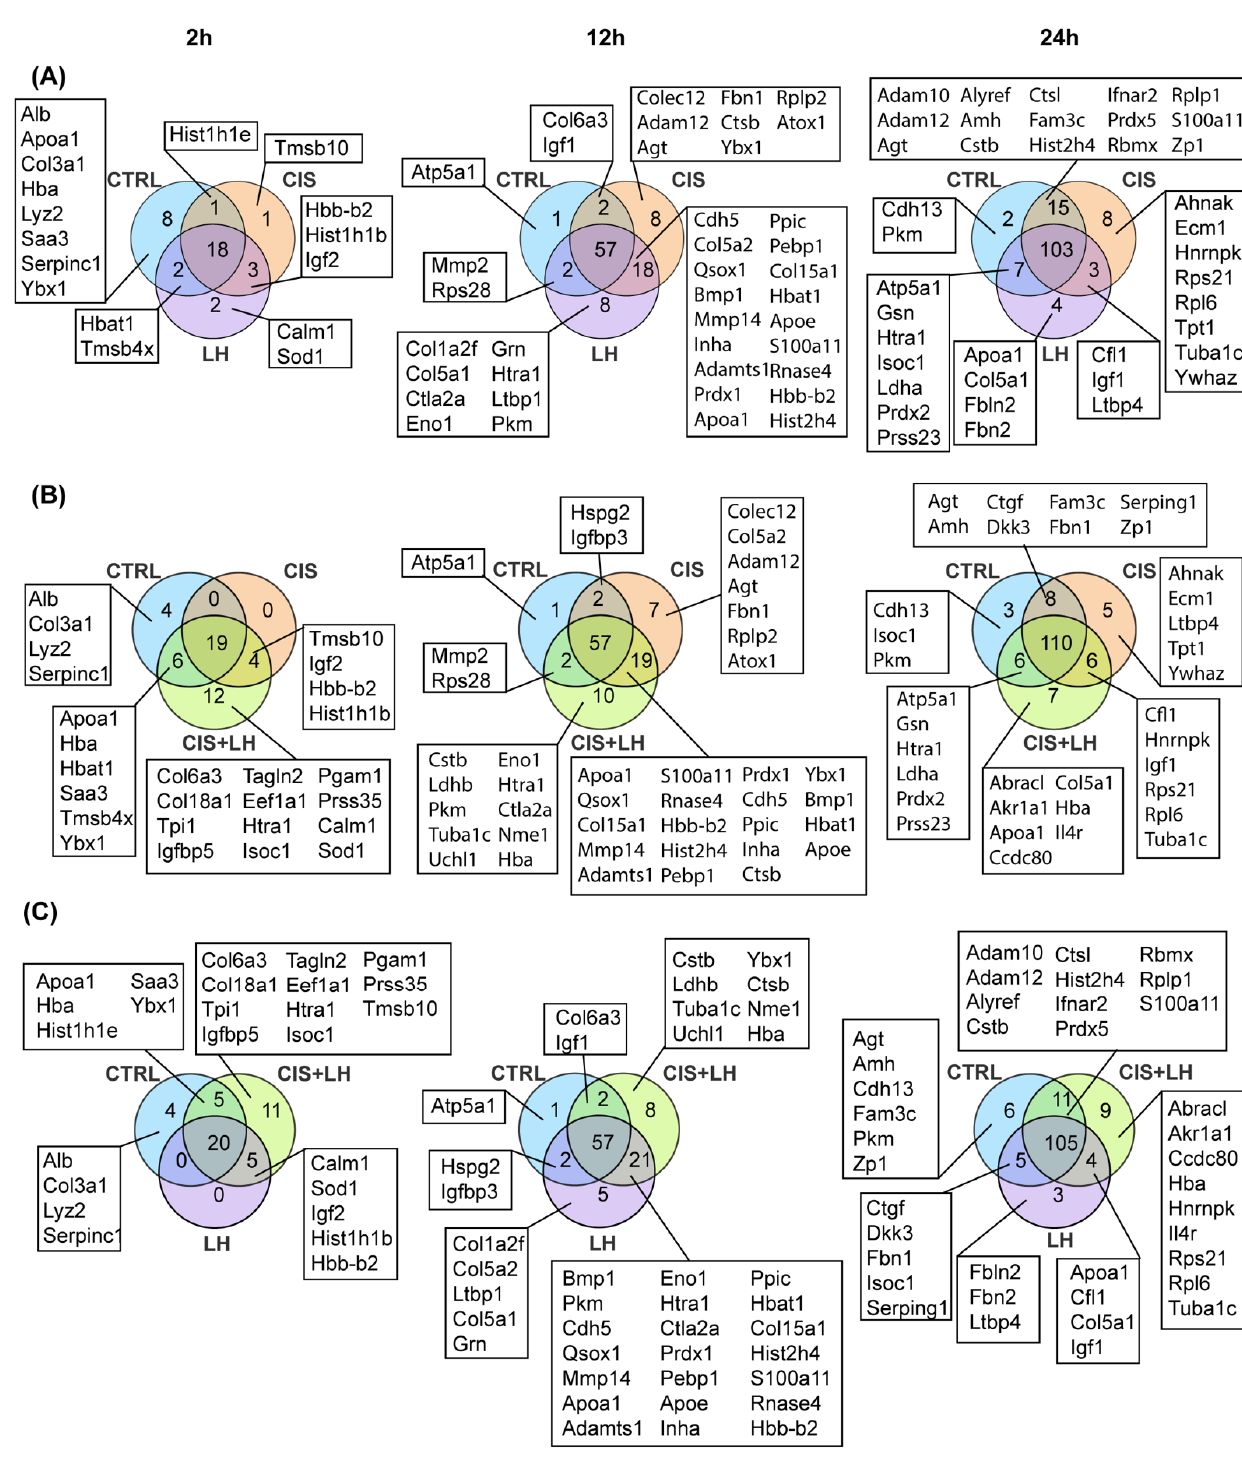
Figure 6. Venn diagram showing unique and shared proteins between indicated groups. The numbers indicate the metabolites counts in the indicated area. The metabolites are indicated below the diagram for each category, except for those shared among groups considered (reported in Table S4). ( A ) Overlaps between CTRL, LH, and CIS at 2, 12, and 24 h of treatment. ( B ) Overlaps between CTRL, CIS, and CIS + LH at 2, 12, and 24 h of treatment. ( C ) Overlaps between CTRL, LH, and CIS + LH at 2, 12, and 24 h of treatment.